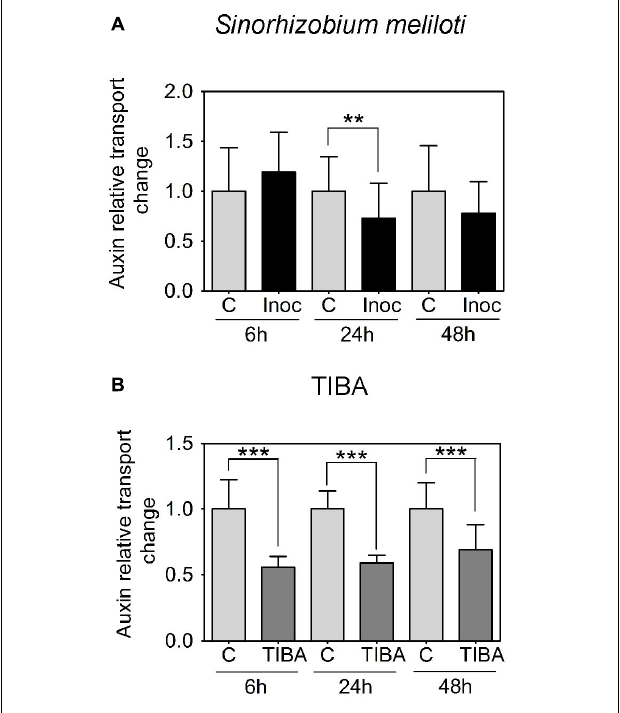
FIGURE 2 | Acropetal auxin transport measurements of M. truncatula root segments. (A) Relative auxin transport changes were measured in mock or Sinorhizobium meliloti -spot inoculated root segments at 6, 24, and 48 h.p.i. (B) Relative acropetal auxin transport changes in mock- or TIBA-flood-treated root segments at 6, 24, and 48 h post-treatment. Mann–Whitney U -tests and unpaired t -tests were used for statistical analyses in A and B , respectively